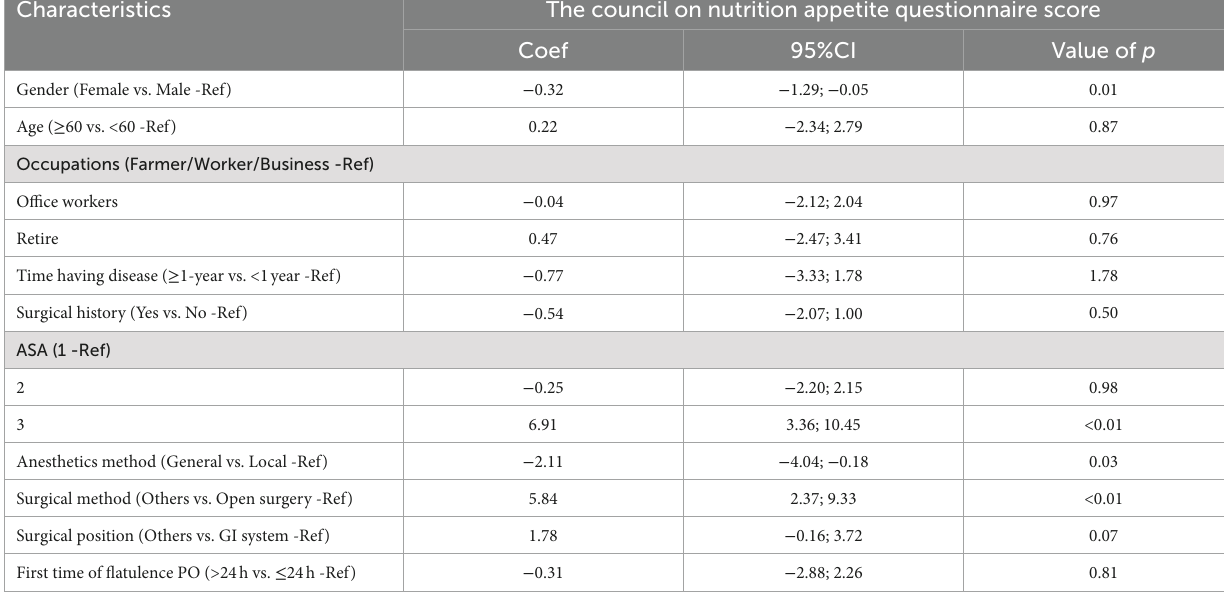
TABLE 4 Factors associated with anorexia among patients.